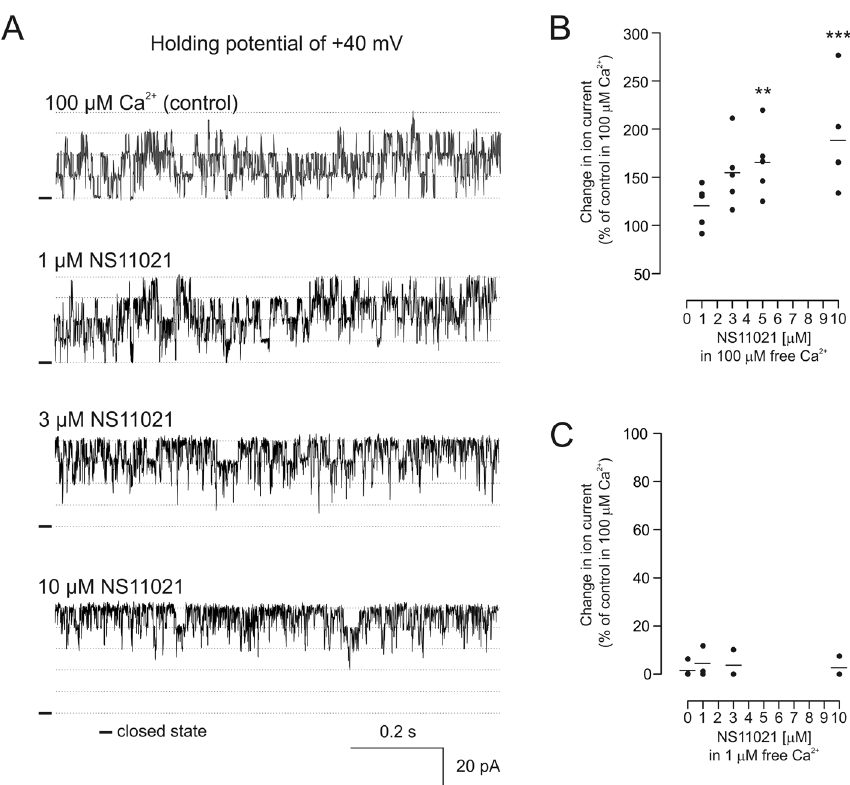
Figure 4. Regulation of channel activity by the BK Ca channel activator NS11021. ( A ) Single-channel recordings in symmetrical 150/150 mM KCl solution at different NS11021 concentrations in the presence of 100 µM Ca